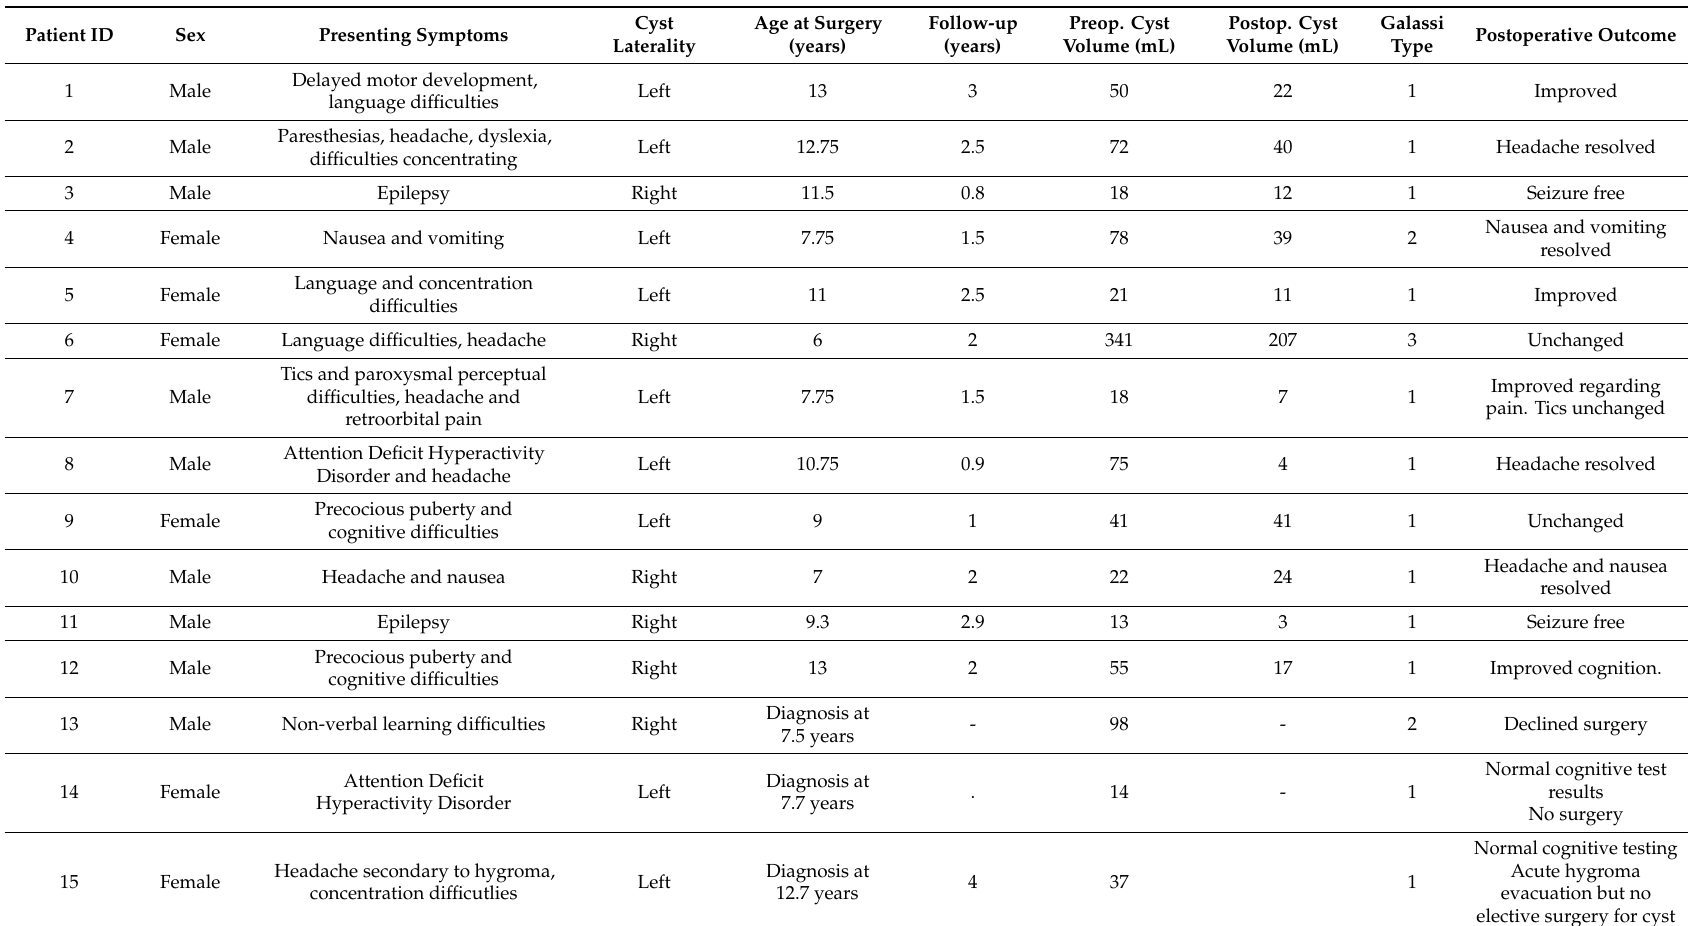
Table 1. Patient